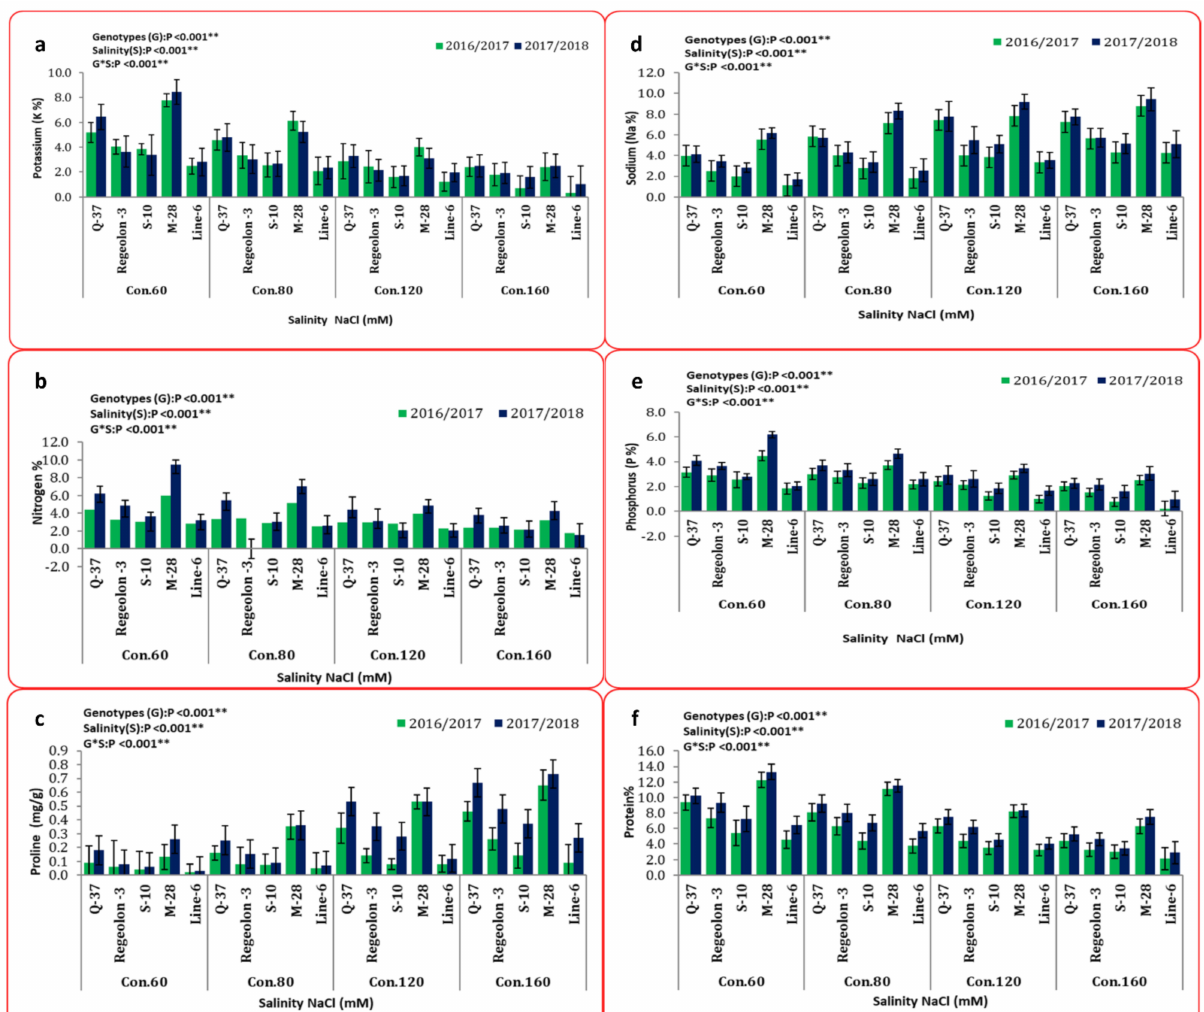
Figure 6. Mean performance (combined data of two seasons) represented as (mean ± SD) for biochemicals traits: ( a ) potas- sium, ( b ) Nitrogen, ( c ) proline, ( d ) sodium, ( e ) phosphorus, and ( f ) protein. All data are means of three replicates. Two-way ANOVA was performed to test the effect of different quinoa genotypes on the studied traits. For all statistical tests, p values ≤ 0.01 ** were considered highly statistically significant.at 0.01% probability